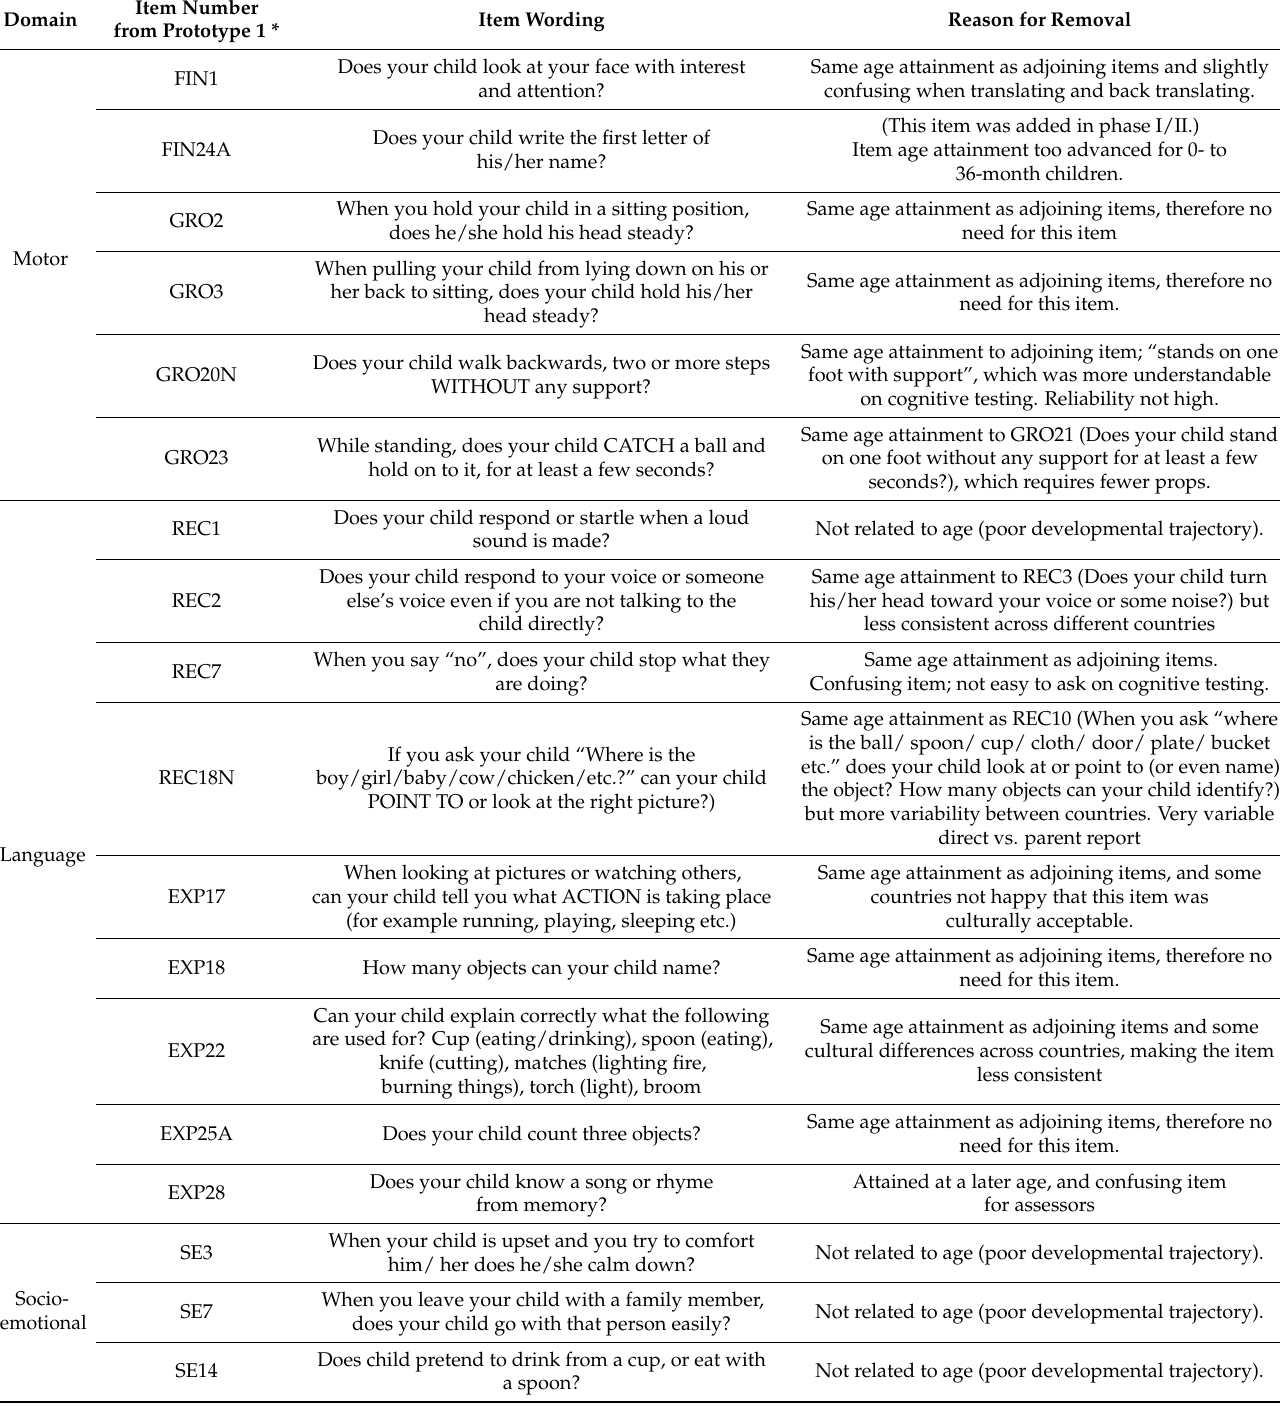
Table 4. Table of items in IYCD prototype removed and reasons